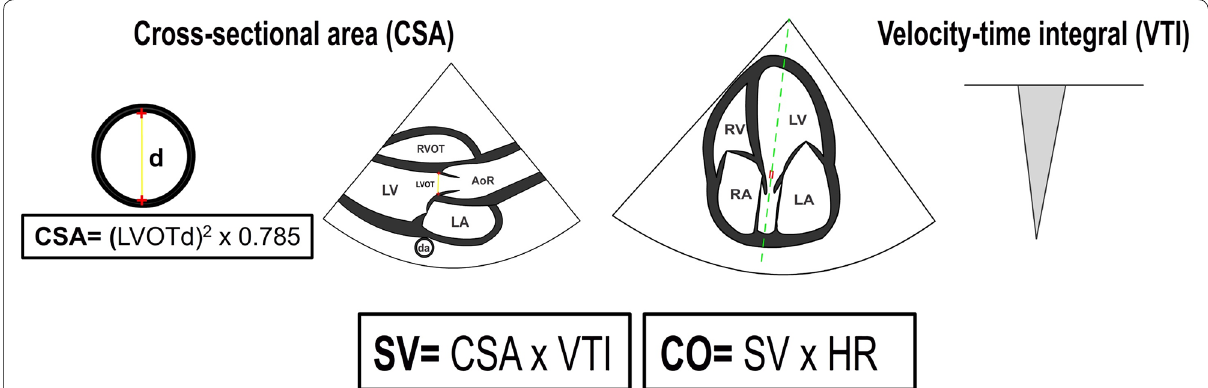
Fig. 1 Schematic representation of the calculation of the stroke volume (SV) and cardiac output (CO) by transthoracic echocardiography. CSA: cross-sectional area; LVOT: left ventricular outflow tract; d: diameter; RVOT: right ventricular outflow tract; LV: left ventricle; AoR: aortic root; LA: left atrium; da: descending aorta; RA: right atrium; RV: right ventricle; VTI: velocity–time integral; HR: heart